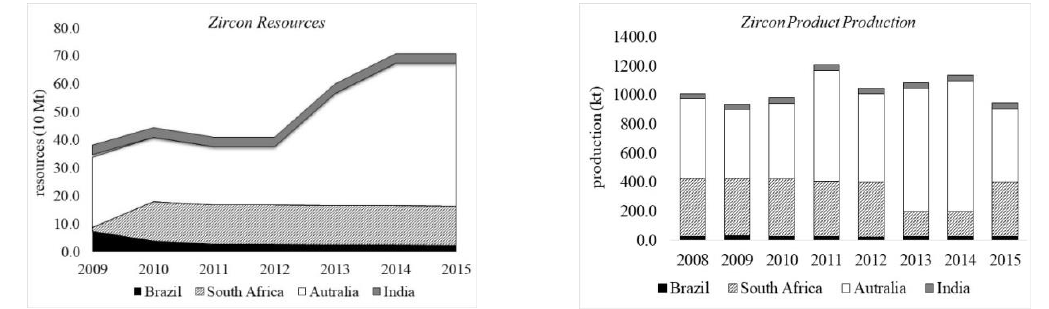
Figure 2. Brazilian resources and the production of ilmenite, rutile, and zircon concentrates, in comparison with the main global producers. Compiled from [1].